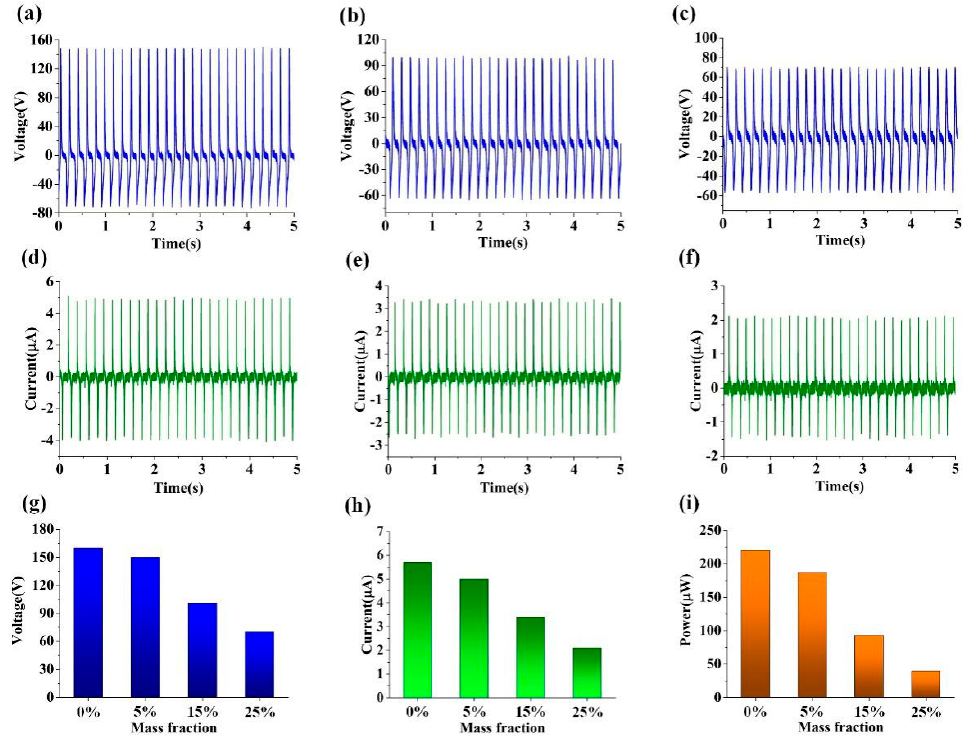
Figure 6. Electrical measurements of three copper TENGs treated with di ff erent concentrations of a sodium chloride solution. ( a – c ) Approximate open-circuit voltage (Voc) and ( d – f ) short-circuit current (I SC ) values of the treated copper TENGs. Comparison of the approximate Voc ( g ), I SC ( h ), and value of max output ( i ) power for the copper TENGs.